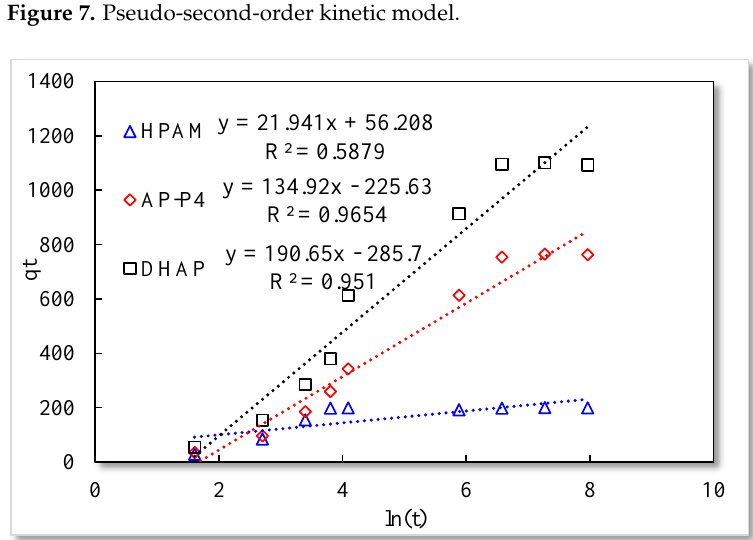
Figure 8. Elovich Figure 8. Elovich model.